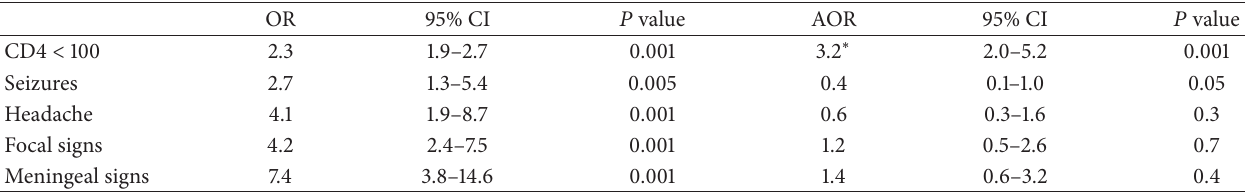
Table 5: Univariate and multivariate (adjusting for sex and CD4 count) analysis of factors associated with death among 300HIV positive patients with CNS